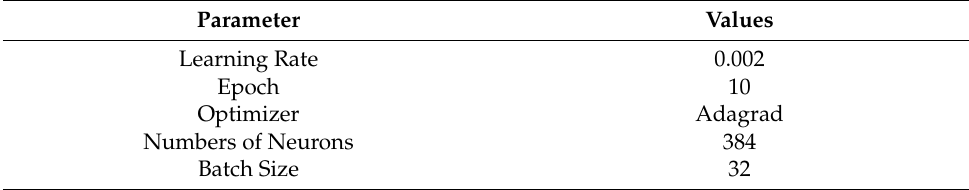
Table 4. Parameters Setting of